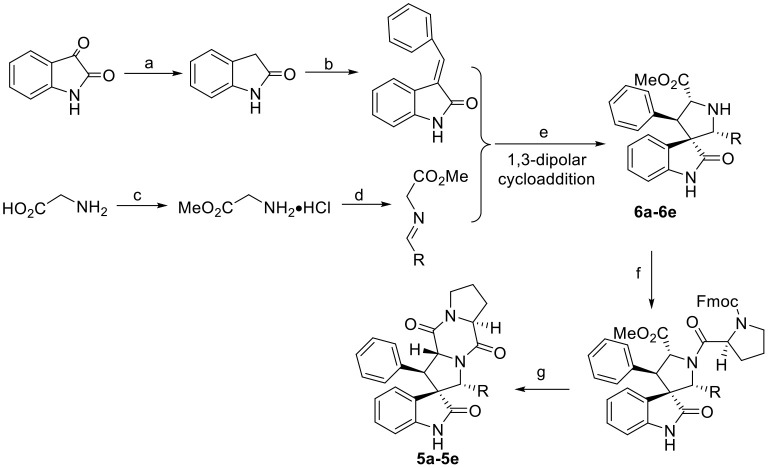
Synthesis route of the target compounds 5a−5e and intermediate 6a−6e. Reaction conditions: (a) EtOH, NH2NH2·H2O, NaOH; (b) benzaldehyde, EtOH, piperidine; (c) SOCl2, MeOH; (d) aromatic aldehyde, TEA; (e) (S)-TF-BiphamPhos/AgAcO, TEA, DCM; (f) Fmoc-L-Pro-Cl, TEA, DCM/Na2CO3(aq); (g) morpholine, DCM.